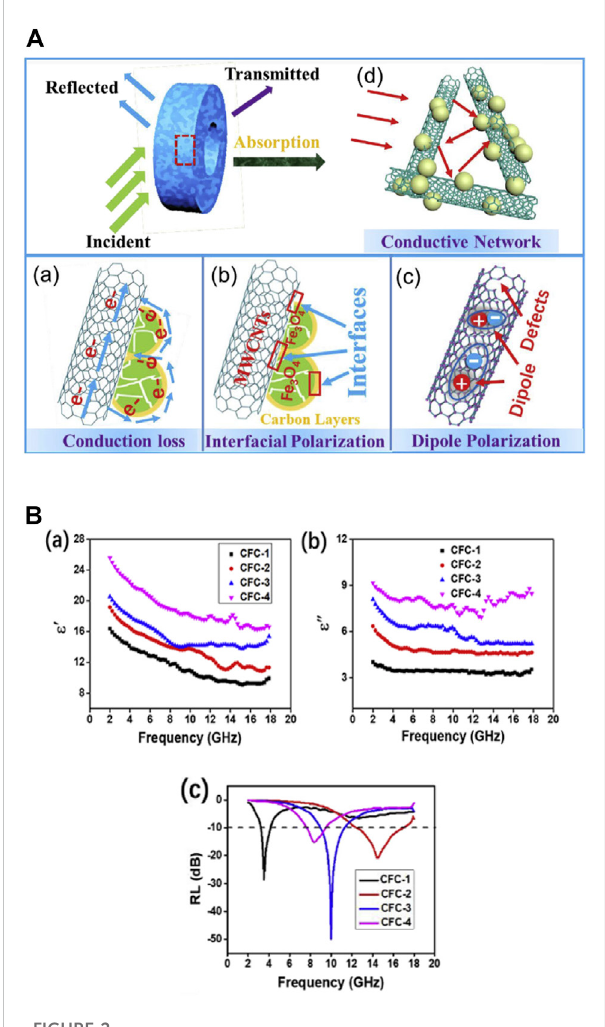
FIGURE 2 (Aa – d) Related microwave absorption mechanisms of C@ Fe 2 O 3 @MWCNT composites, (Ba) real parts of the complex permittivity ( ε ′ ), (Bb) imaginary parts of the complex permittivity ( ε ’’ ), and (Bc) the strongest absorption curve of the samples (Wang et al.,